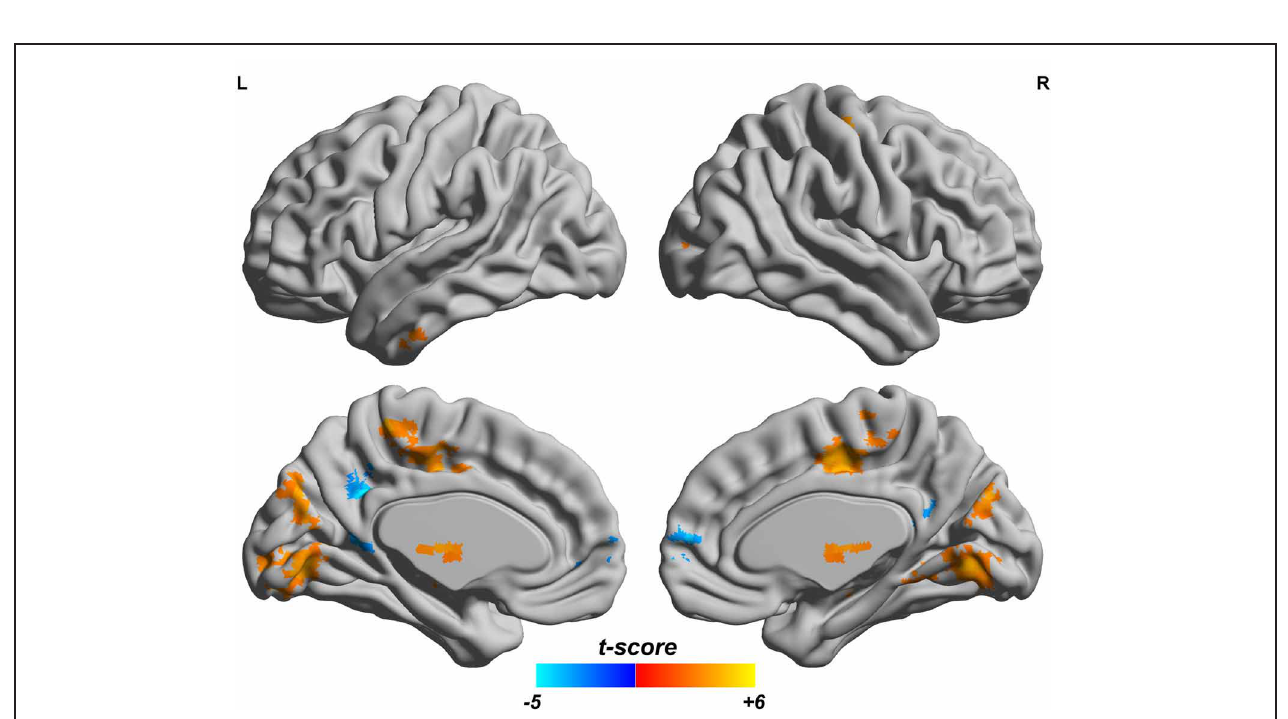
FIGURE 4 | ReHo difference map between the ADHD patients and healthy controls. T-score bar is shown at the bottom. Warm and cold colors indicate ADHD-related ReHo increase and decrease, respectively. Threshold is set at p < 0 . 05 (AlphaSim correction).